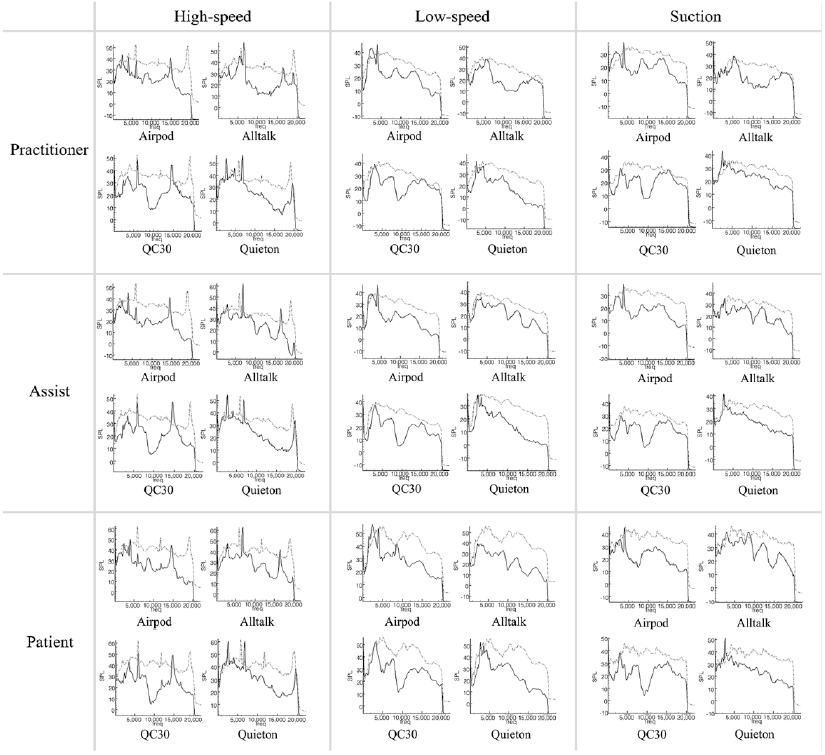
Figure 4. Comparison of sound pressure level not during tooth preparation. Dash − dot graph represents control condition (dental noise) and solid graph represents experimental condition (active noise control devices).